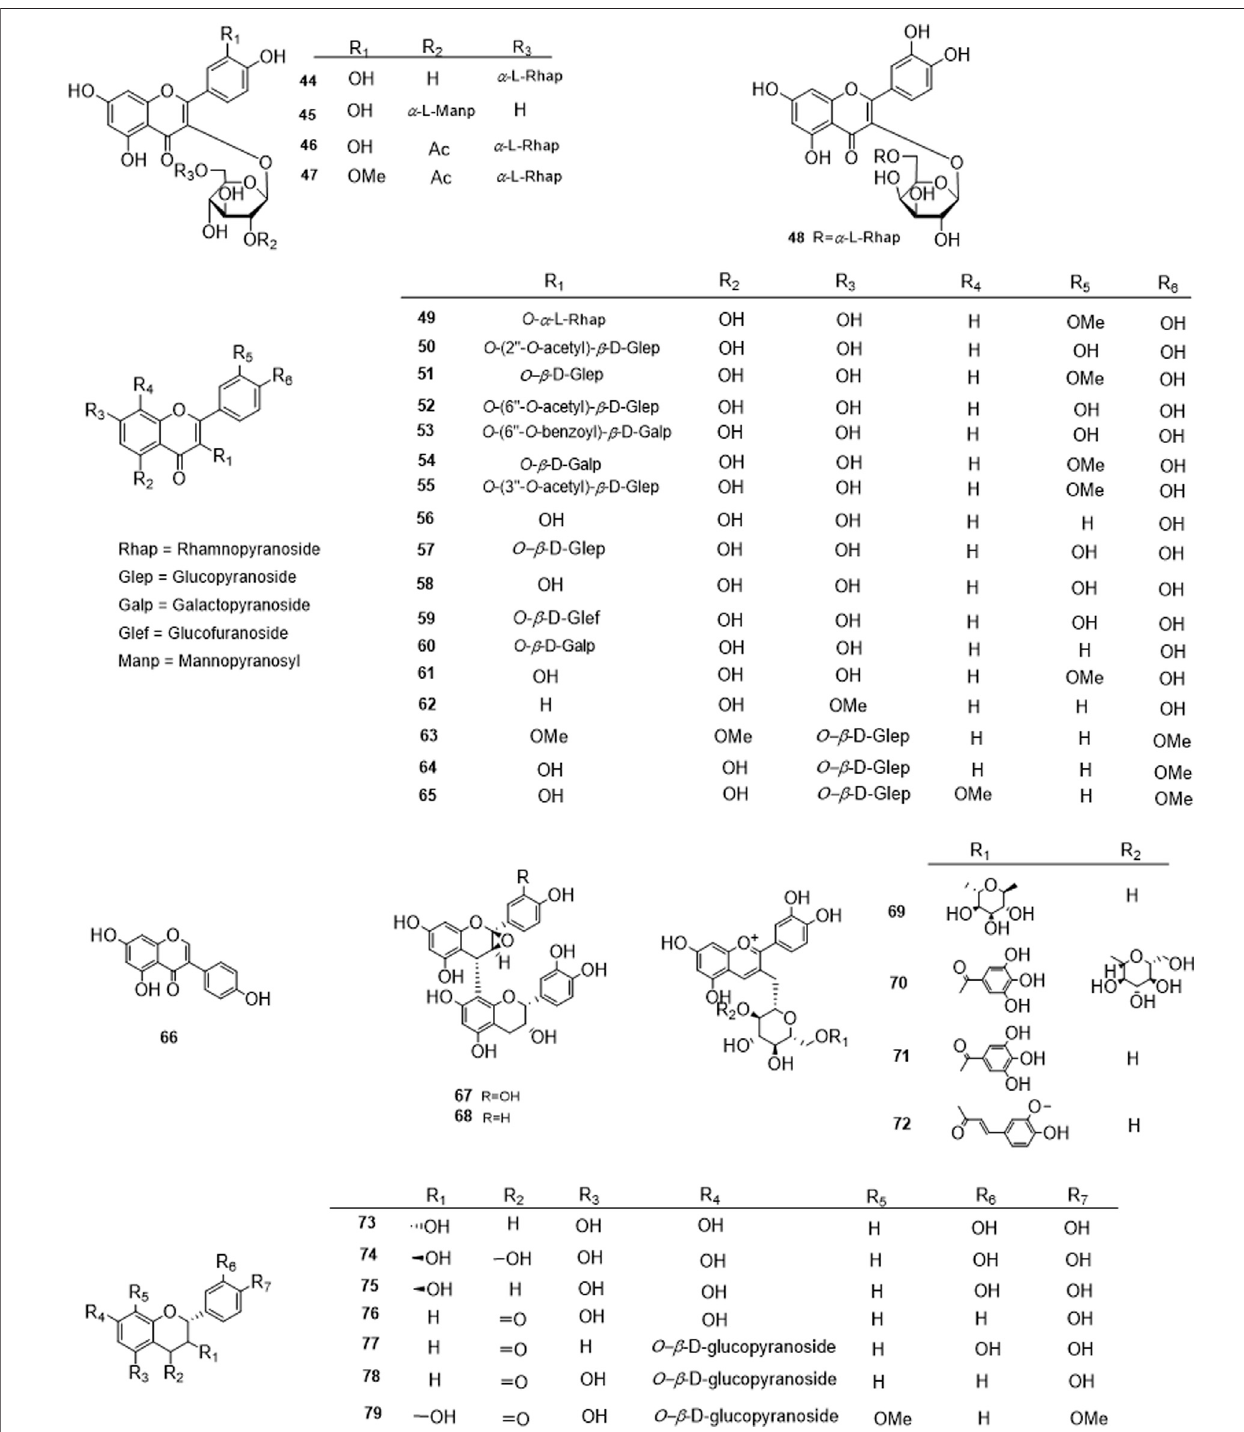
FIGURE 3 | Structures of the fl avonoids acid derivatives (44 – 79) form P. mume .